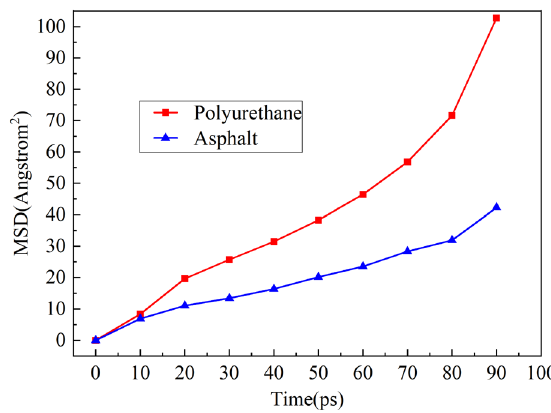
Figure 12: Forcite dynamics temperature.